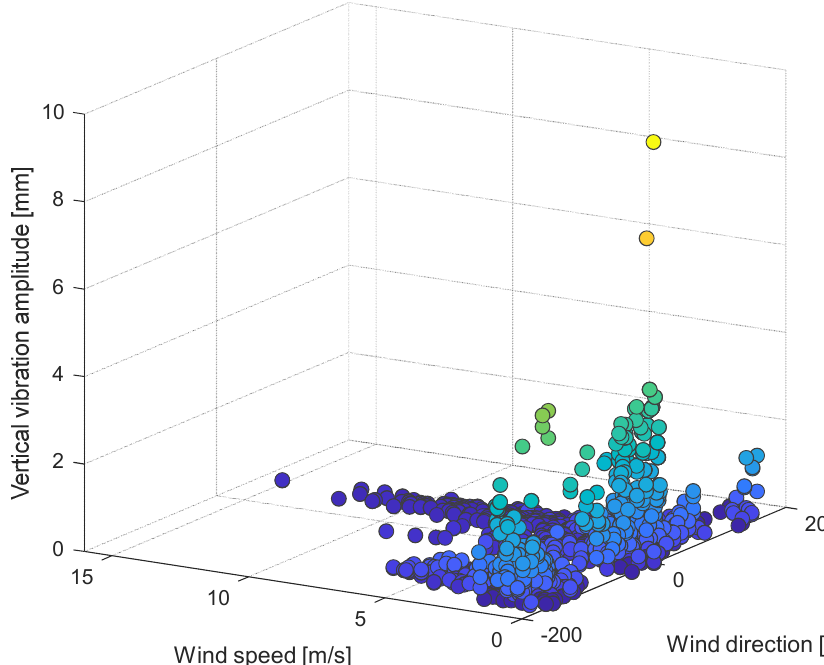
Figure 17. Correlation between maximum vertical amplitudes of vibration, wind speed and wind direction. Lighter colors indicate higher values of vibration amplitudes.